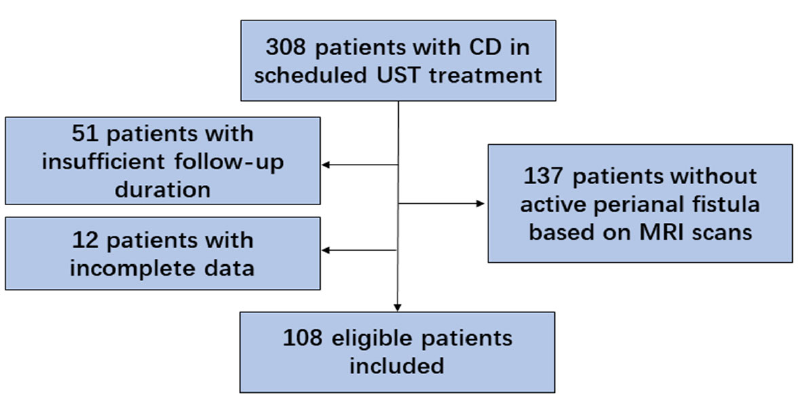
Figure 1. Flow chart of the study (CD, Crohn’s disease; UST, ustekinumab; MRI, magnetic resonance imaging). Table 1. Baseline characteristics of overall patients.